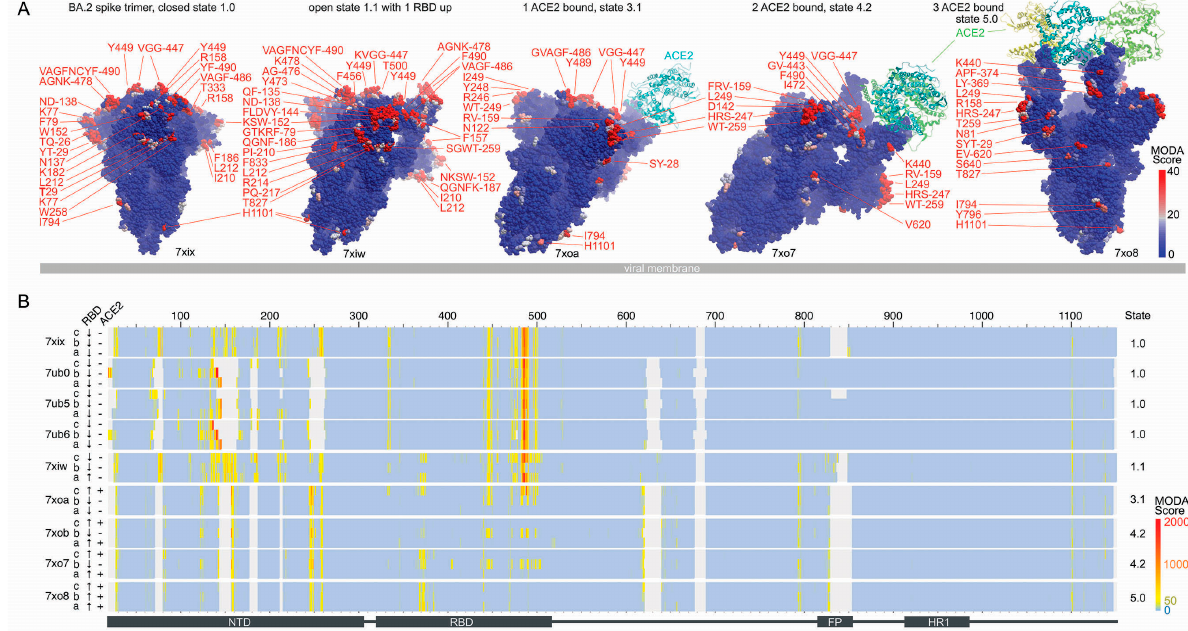
Figure 2. Comparison of membrane binding by BA.2 spike conformational states. ( A ) The structures of five states are shown as blue surfaces with residues having significant and substantial membrane binding propensities coloured pink and red, respectively, as indicated in the scale. The PDB entries are labeled below the structures. The viral membrane is shown as a grey slab, and the spike trimer is tilted to position the membrane binding surfaces towards the host cell above. ( B ) The heatmap shows the membrane binding propensities of residues in BA.2 spike trimer structures, with the RBD position and ACE-2 occupancy labelled on the left side. Positions are coloured light blue–yellow–red to indicate MODA scores from 0-50-2000 as in the scale, while light grey indicates missing coor- dinates.